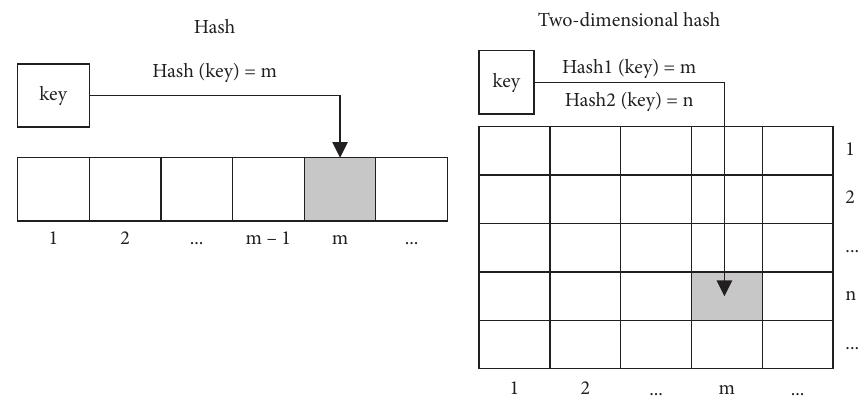
Figure 2: Hash table and two-dimensional